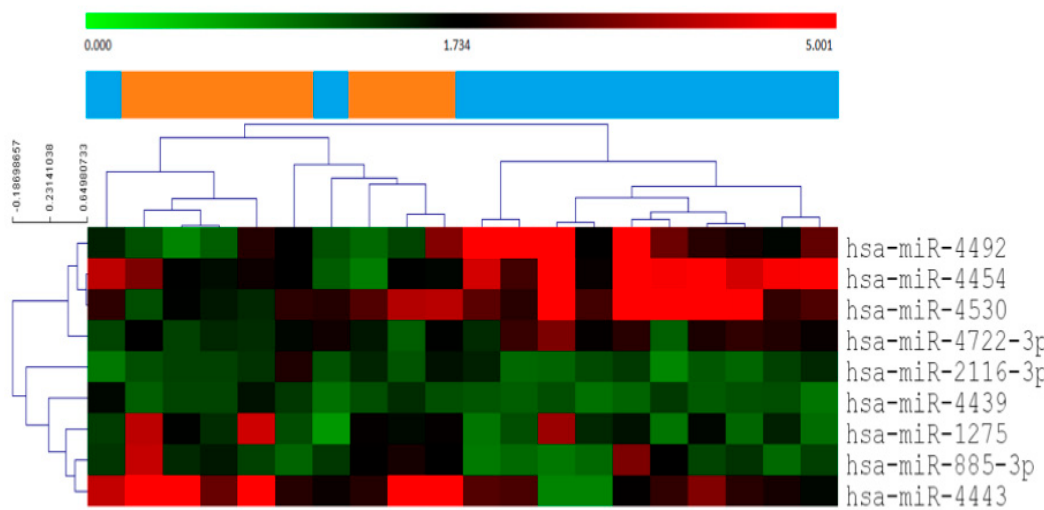
Figure 1. Heatmap with the pseudo ‐ color scale underneath of the differentially expressed miRNAs between complete responder (CR) (blue bar) and partial responder and progressive diseases (PRPD) (orange bar). Unsupervised hierarchical clustering was used to order samples and miRNAs, the log2 ‐ transformed microarray signal was considered. The sample tree with optimized leaf ‐ ordering was drawn using Euclidean distances and average linkages for cluster ‐ to ‐ cluster distance. CR = complete responder, PRPD = partial responder and progressive diseases.